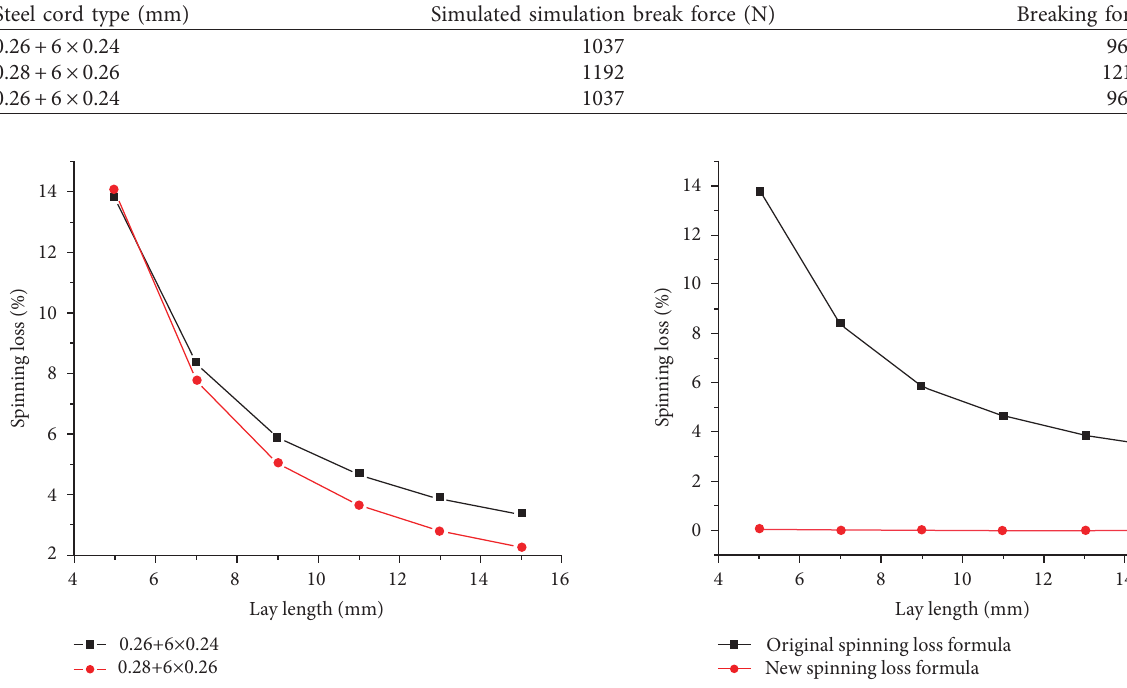
Figure 10: 0.26+6 × 0.24 steel cord new and old formula to make a spinning loss result